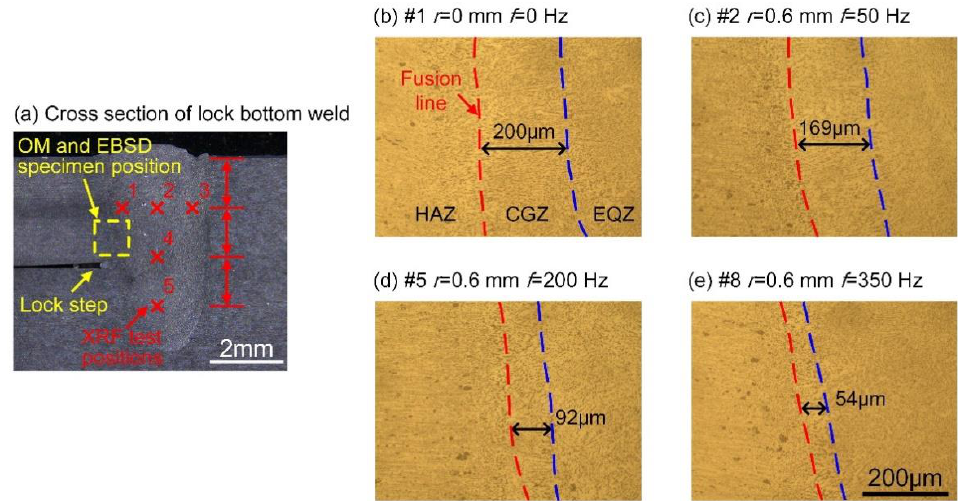
Figure 4. Microstructure near lock step, ( a ) cross section of lock bottom weld; ( b ) r = 0 mm, f = 0 Hz; ( c ) r = 0.6 mm, f = 50 Hz; ( d ) r = 0.6 mm, f = 200 Hz; ( e ) r = 0.6 mm, f = 350 Hz.